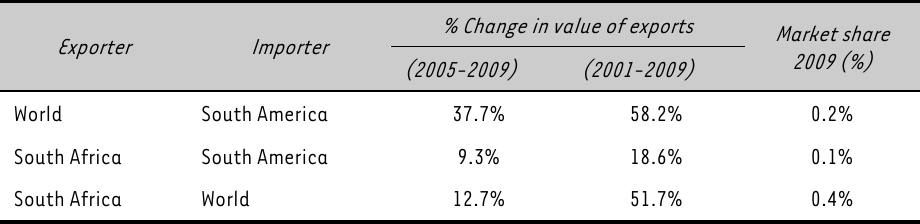
TABLE 1: Growth in exports from South Africa and the world to South America (2001-2009) % Change in value of exports Market share Exporter Importer 2009 (%) (2005-2009) (2001-2009) World South America 37.7% 58.2% 0.2% South Africa South America 9.3% 18.6% 0.1% South Africa World 12.7% 51.7%